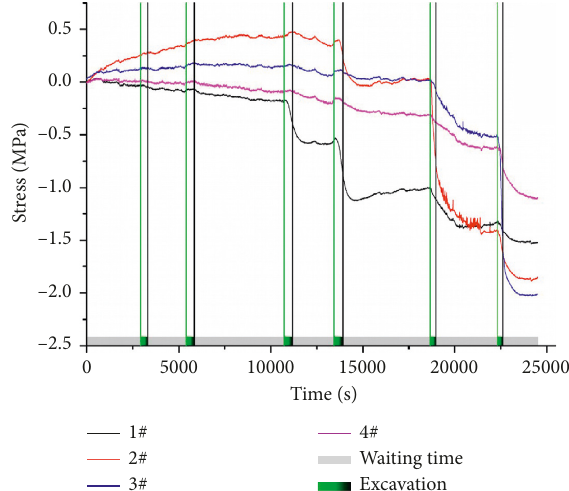
Figure 7: Stress evolution diagram during the whole